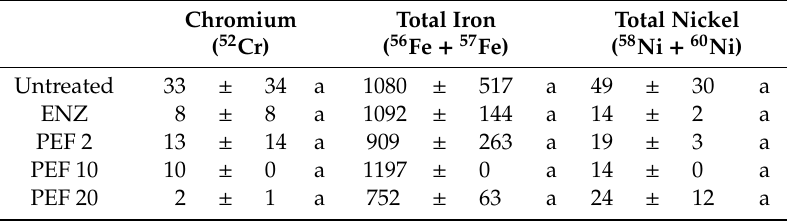
Table 2. Concentrations (means ± SD) of chromium, iron, and nickel detected in the wines after twelve months of bottle storage. The values are expressed in µ g L − 1 . Di ff erent letters mark significant di ff erences according to ANOVA and Tukey HSD test ( p < 0.05). Refer to Table 1 for sample